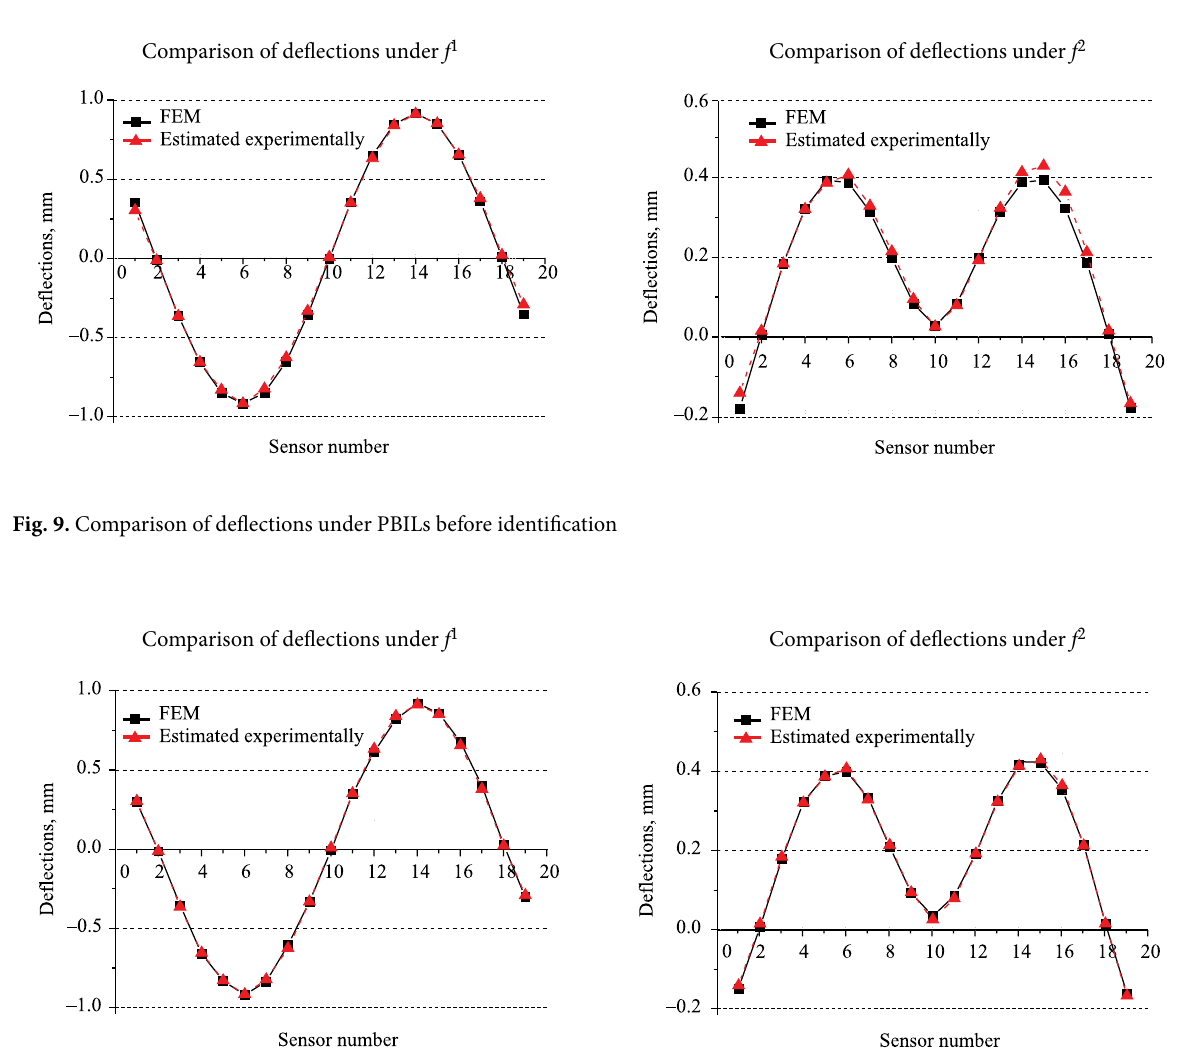
Fig. 10. Comparison of deflections under PBILs after identification